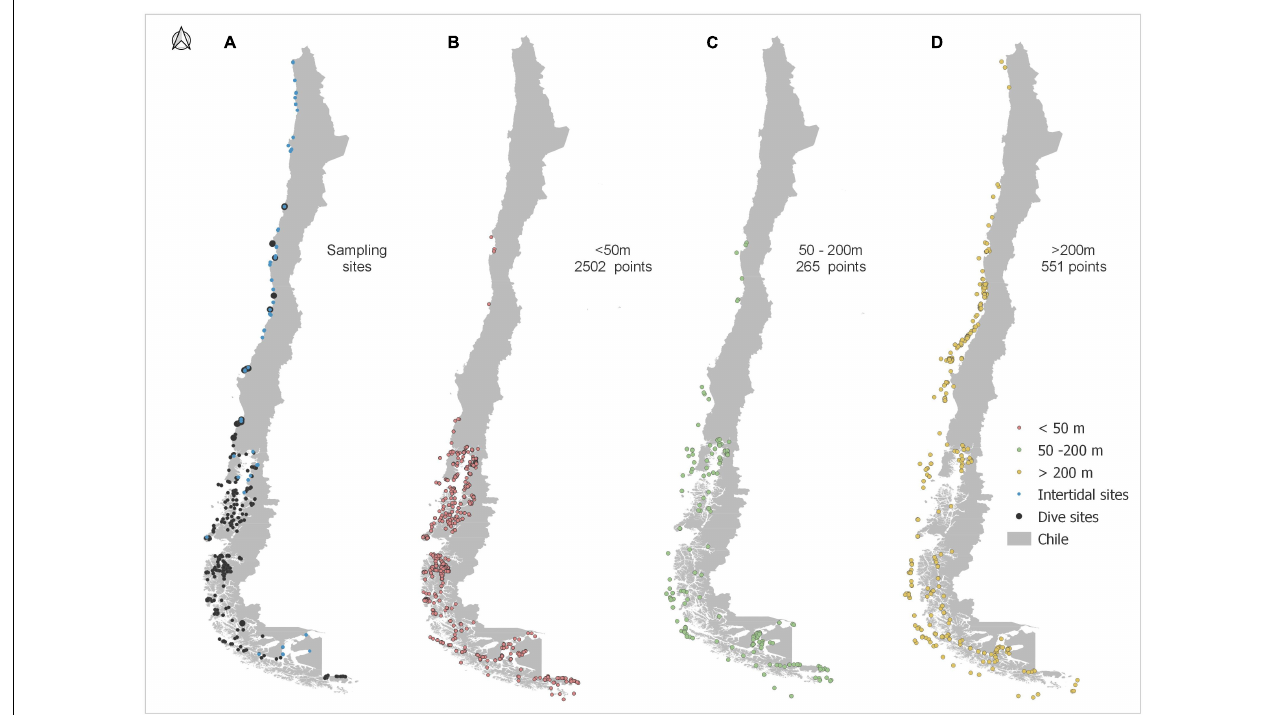
FIGURE 1 | (A) Sampling sites. Black points represent dive sites and blue points intertidal study sites. (B–D) Sites of invertebrate presence data along the Chilean coast from both PAMADA and SCBUCN (total 3331 points). (B) Presence data < 50 m depth. (C) Presence data 50–200 m depth. (D) Presence data > 200 m depth.